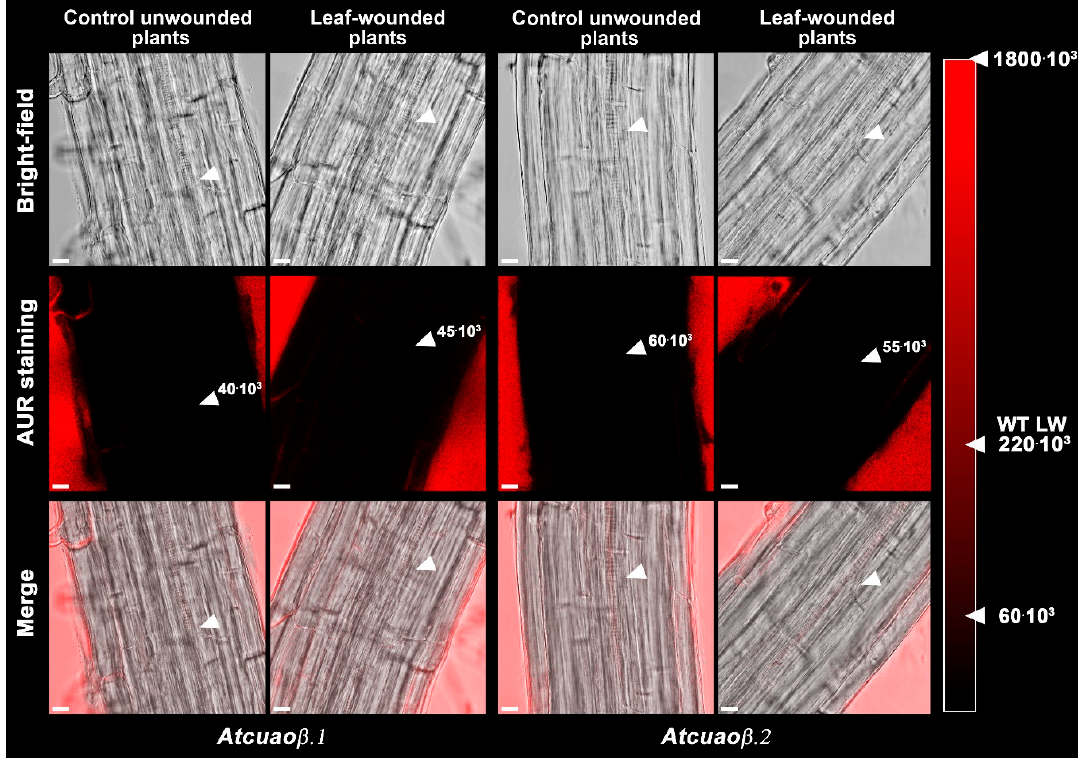
Figure 3. In situ H 2 O 2 detection by LSCM analysis, after AUR staining, of roots from 7 ‐ day ‐ old unwounded control and leaf ‐ wounded mutant seedlings ( Atcuao β .1 and Atcuao β .2 ) 6 h after the injury. The corresponding bright ‐ field and overlay images are shown. Micrographs show the root zone corresponding to the site of appearance of the first protoxylem cell with fully developed secondary cell wall thickenings (arrows) and have been taken at the level of the central root section. Images are representative of those obtained from ten seedlings from three independent experiments. The average values of fluorescence intensity measured as the sum of the pixels of each of five 65 μ m 2 rectangle are reported for each condition (mean values ± SD; n = 25). The maximum pixel sum for a completely saturated square was approximately 1800 × 10 3 . In the red degrading scale are reported for comparison the average values of fluorescence intensity for unwounded control and leaf ‐ wounded (LW) WT plants that respectively were 60 × 10 3 ± 19 × 10 3 and 220 × 10 3 ± 38 × 10 3 (data from [10]). Bars: 10 μ m.